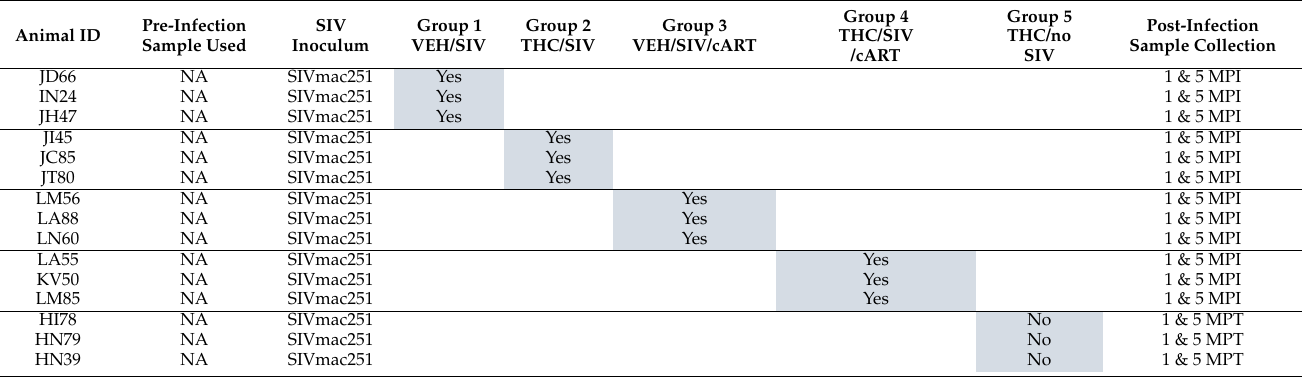
Table 1. Animal IDs, SIV inoculum, infection duration, ∆ 9 -THC administration, and ART treatment. Animal ID